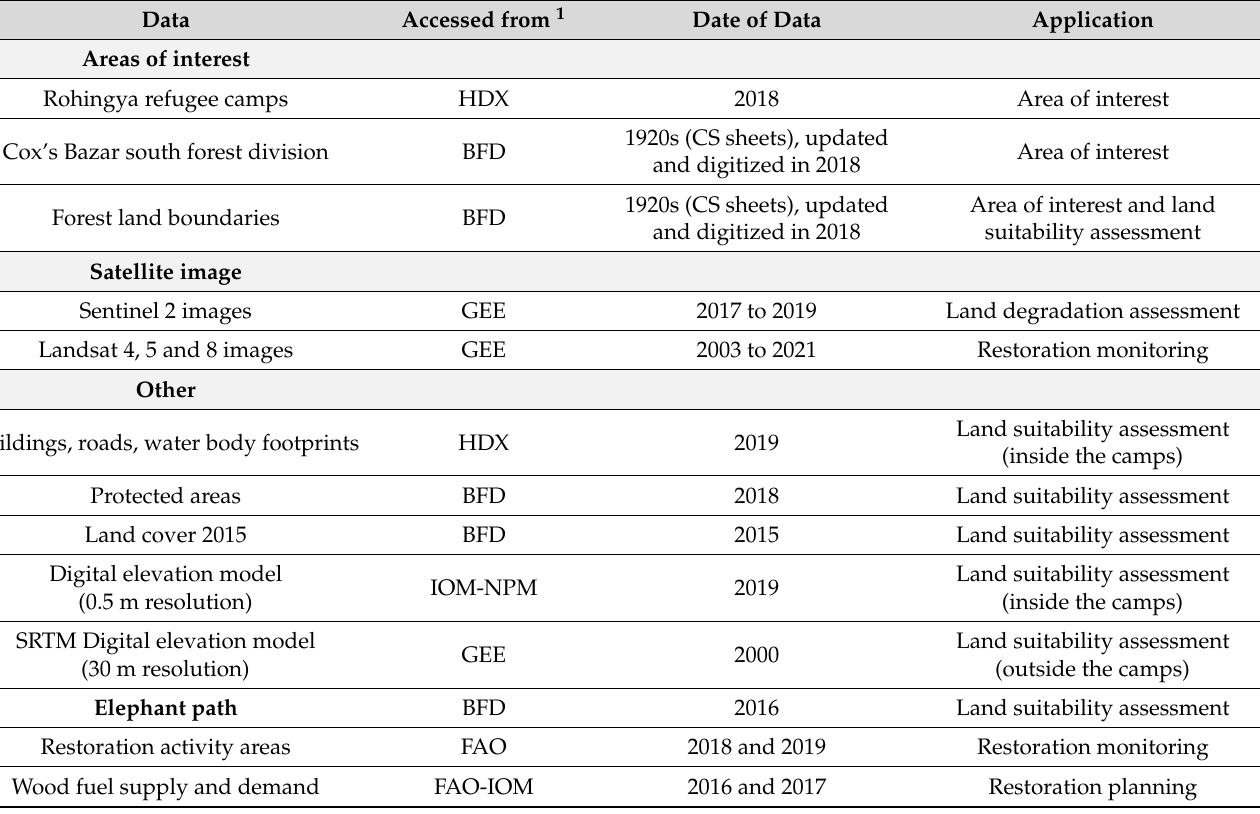
Table 1. Data used in different stages of addressing land degradation.